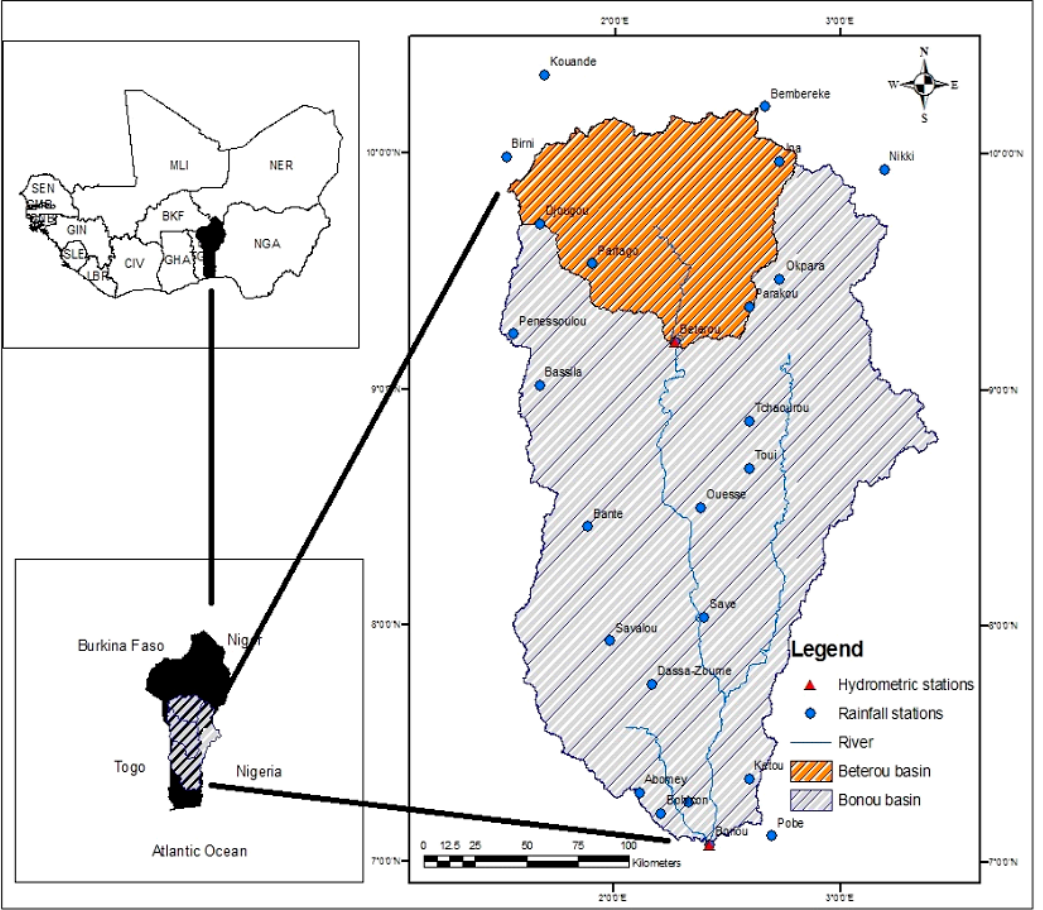
Figure 1. Study areas and the hydrometeorological stations used.